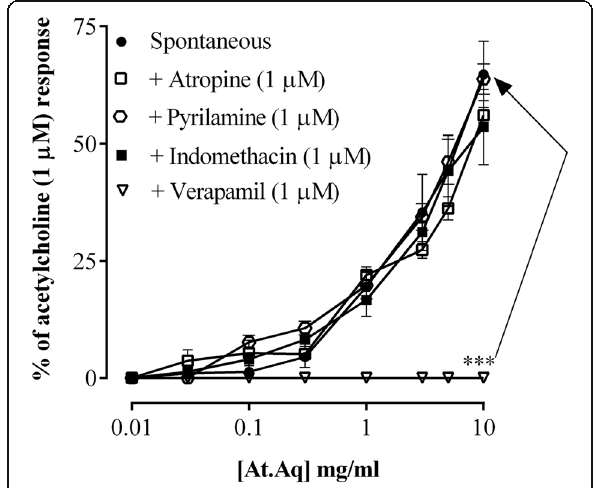
Fig. 7 Effects of Asphodelus tenuifolius aqueous fraction (At.Aq) upon spontaneous contractions in jejunum preparations alone and in presence of various antagonists. *** p < 0.001 as analyzed by two-way ANOVA with Dunnett ’ s test. Values are mean ± SEM ( n =